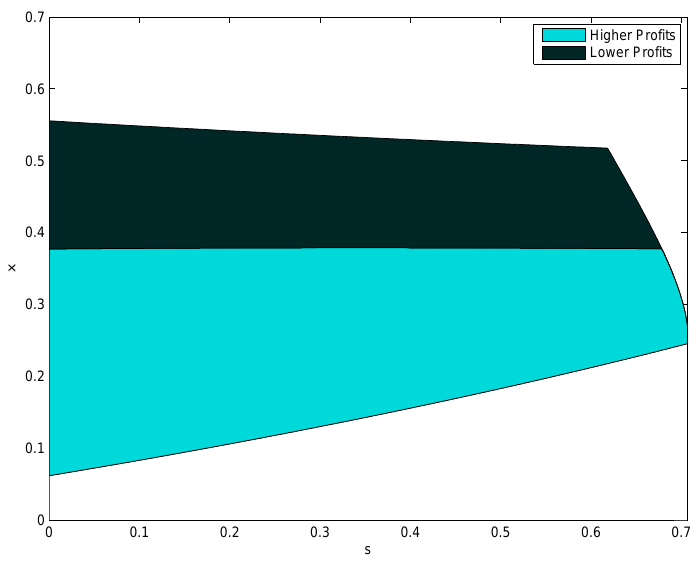
Figure 2: Ex-ante profits of the overconfident player in the cost-dependent equi- librium versus ex-ante profits with two rational players